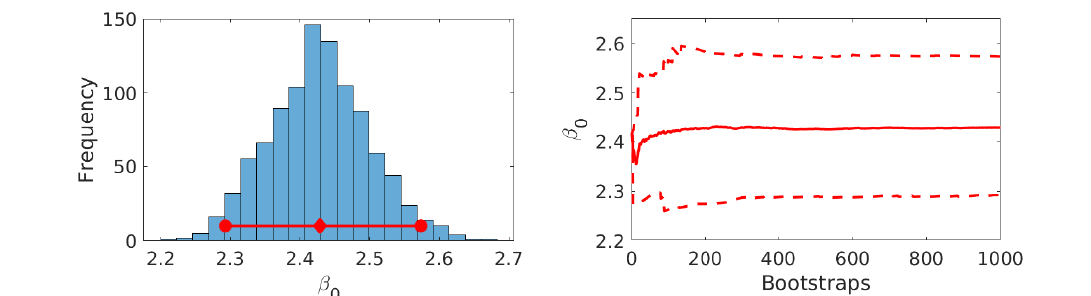
Figure 8. Results for parameter estimation for Brownian motion kernel with parametric bootstrap data: Histogram of bootstrapped parameter set, confidence interval ¯ β 0 (red rectangle) ( Left ) Change of runs ( Right